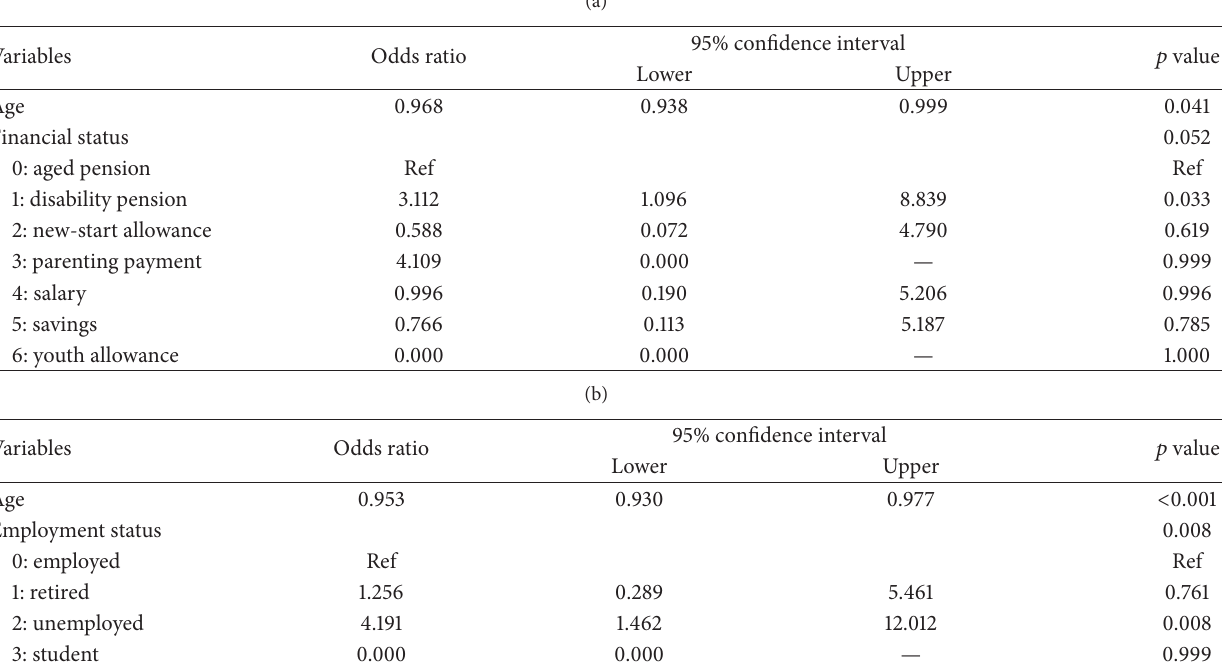
Table 4: Multivariate logistic regression showing independent predictors of nonadherence.